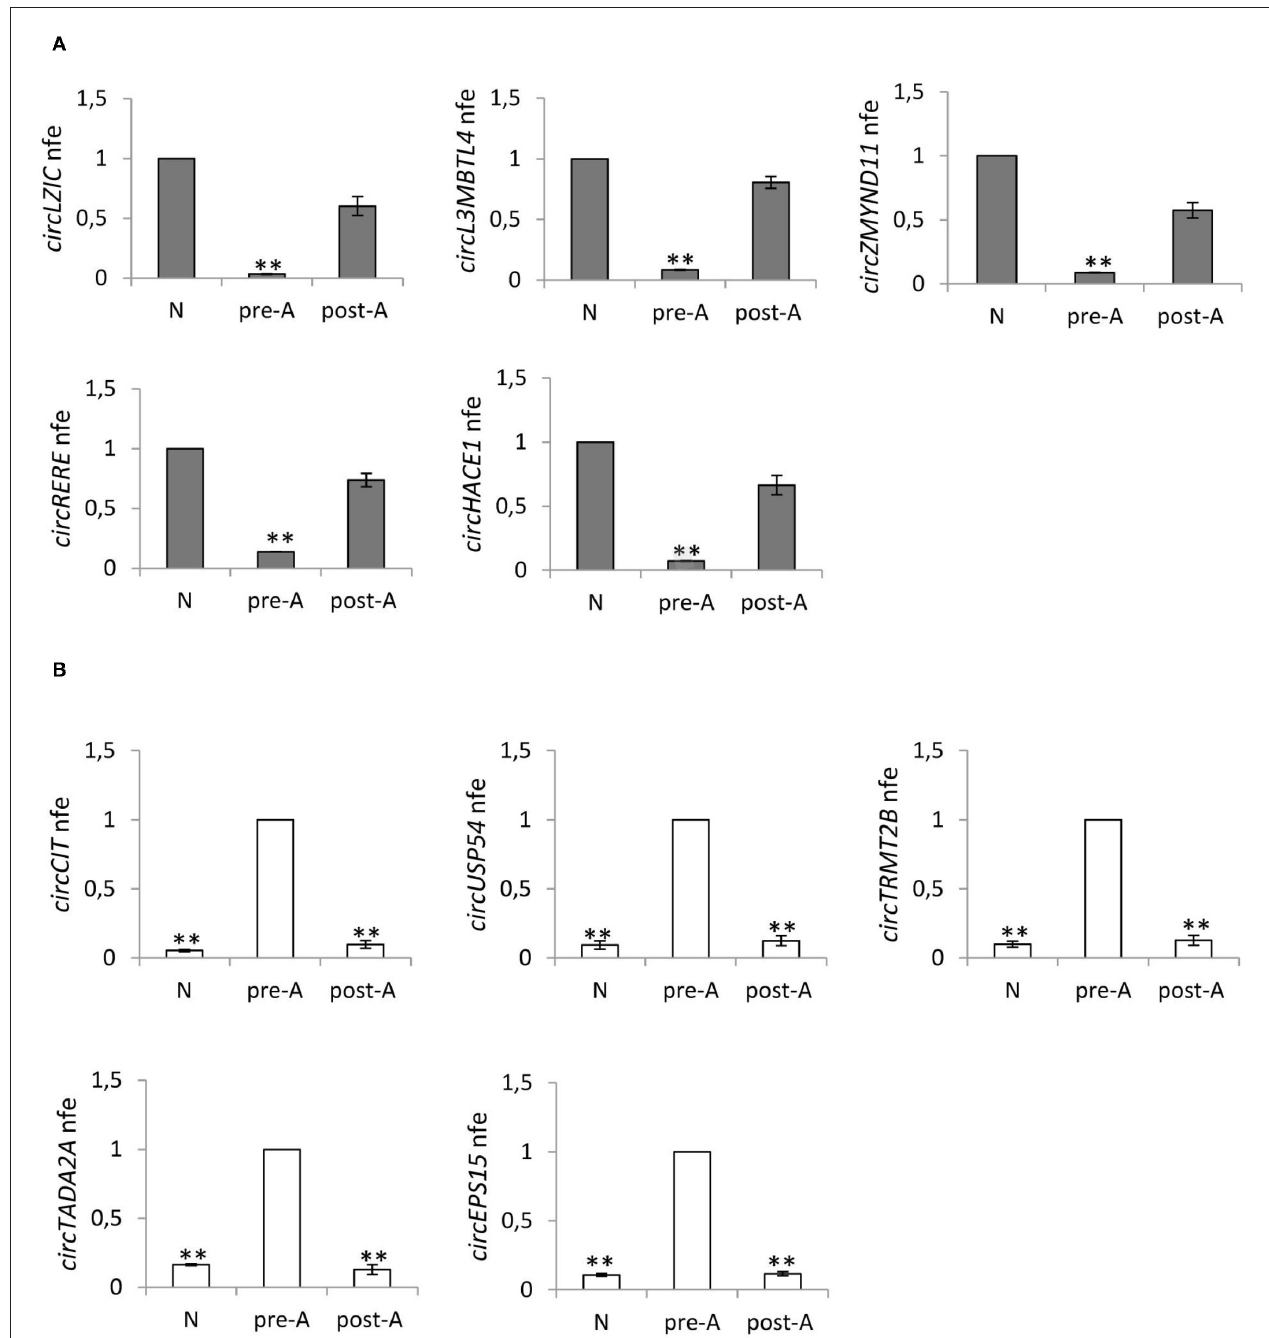
FIGURE 6 | (A) Expression of five circRNAs up regulated in A normozoospermic derived SPZ (N) compared to A asthenozoospermic derived SPZ from men pre- (pre-A) and post-treatment with oral amino acid supplement (post-A); ** p < 0.01. (B) Expression of five circRNAs up-regulated in A asthenozoospermic derived SPZ from men pre-treatment with oral amino acids supplement (pre-A) compared to A normozoospermic derived SPZ (N) and to A asthenozoospermic derived SPZ from men post-treatment with oral amino acids supplement (post-A); ** p < 0.01.